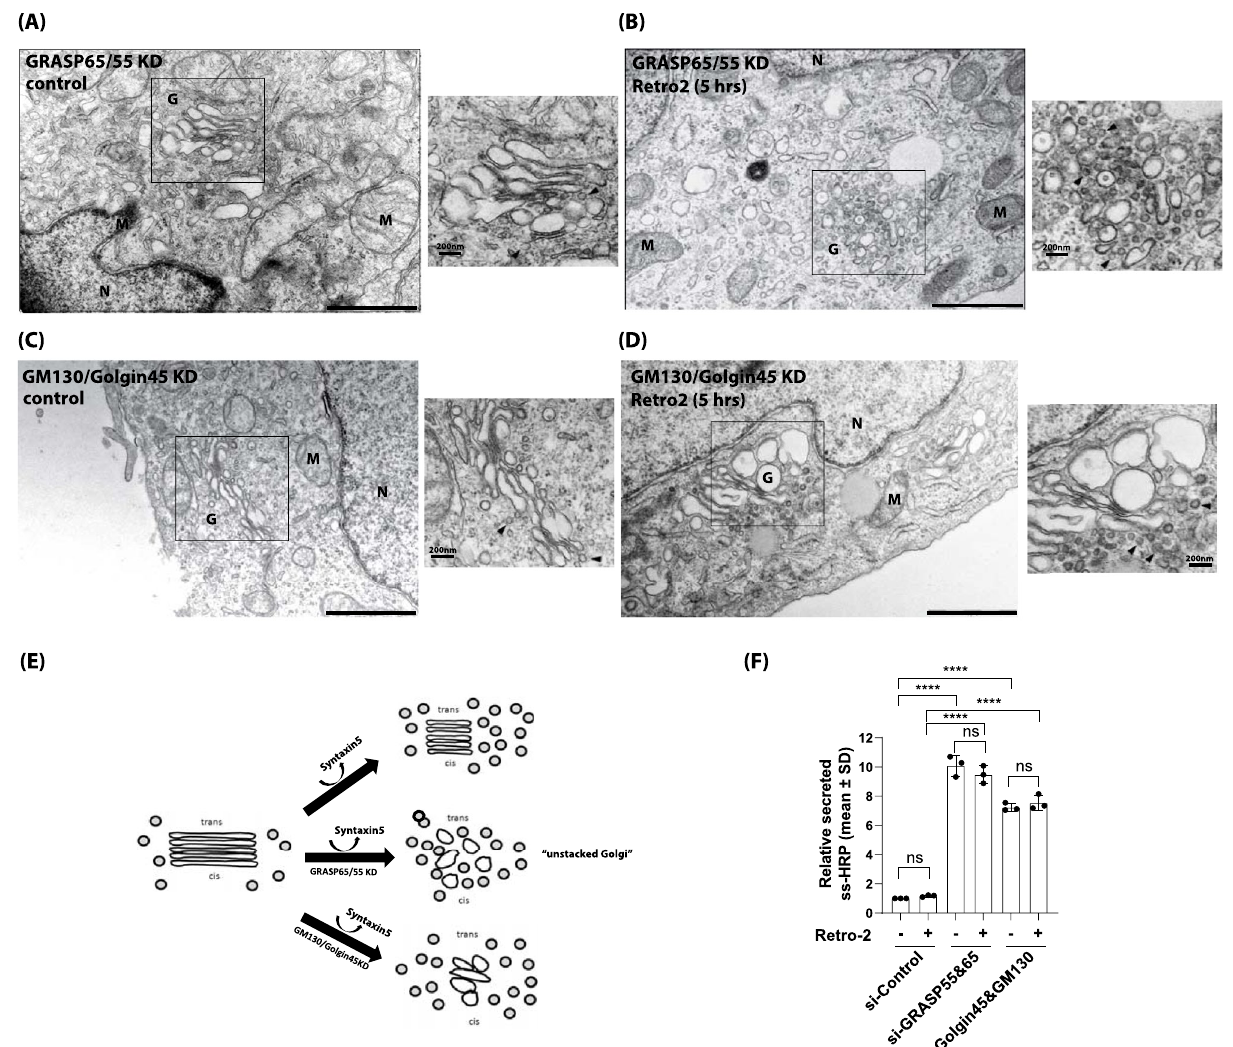
Figure 4. Acute removal of Syntaxin5 from the Golgi by Retro-2 induces Golgi unstacking in GRASP65/55- depleted cells. ( A , B ) Representative EM photos showing that Retro-2 treatment induces Golgi unstacking in GRASP65/55-depleted cells. Insets show a magnified view of the boxed area. peri-Golgi COPI vesicles are marked by black arrow heads; ( C , D ) representative EM photos showing that Retro-2 treatment does not lead to Golgi unstacking in GM130/Golgin45-depleted cells. Insets show a magnified view of the boxed area; ( E ) illustration summarizing the EM data from Retro-2 treatment experiments using control cells (Fig.